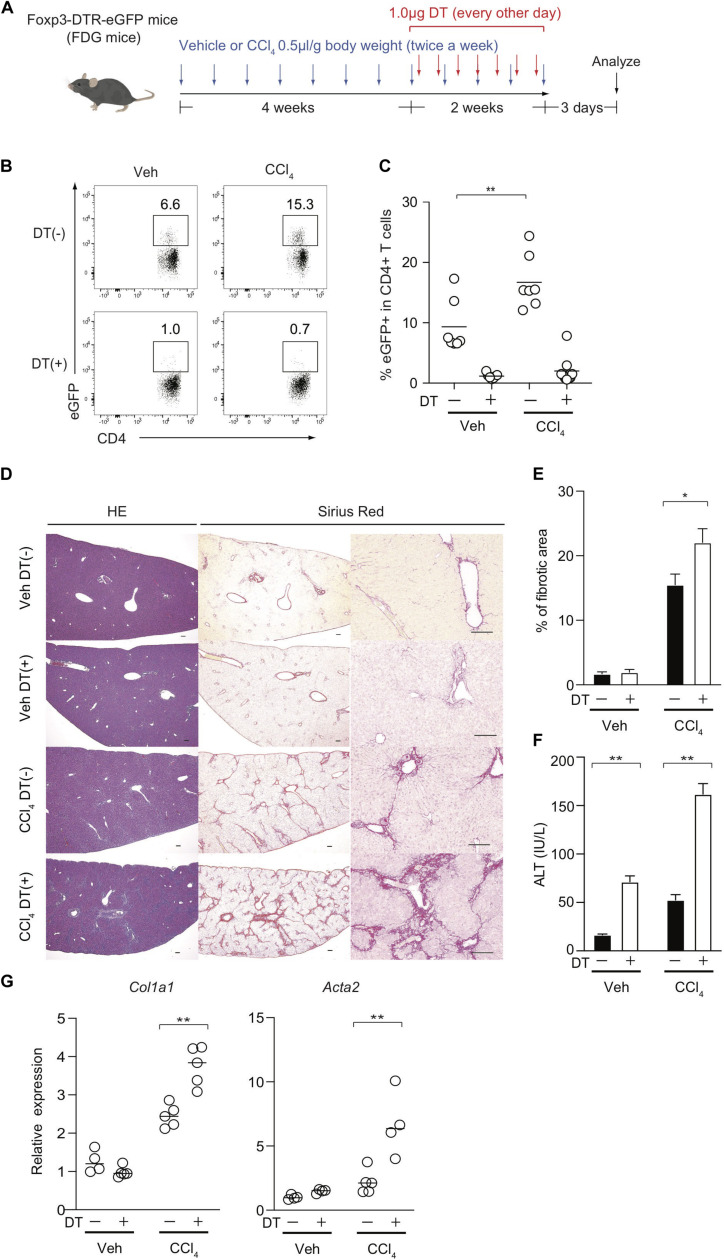
Treg-cell depletion aggravates CCl4-induced liver damage and fibrosis. (A) Experimental design of Treg-cell depletion during CCl4-induced liver injury. FDG mice were untreated or administered diphtheria toxin (DT) during the late phase of CCl4 and vehicle (Veh) treatment. (B,C) Proportions of eGFP+ in hepatic CD4+ T cells of FDG mice with DT(+) or without DT(−) as in panel (A). (D) Representative images of hematoxylin and eosin (H&E) and Sirius red (SR) staining of the liver of DT(−) and DT(+) FDG mice. Scale bars indicate 100 μm. (E) Quantification of fibrotic areas of the liver section evaluated by SR-positive area (n > 5). (F) Serum level of ALT of DT(−) and DT(+) FDG mice (n > 5). Vertical bars denote SD. Horizontal bars indicate the means in pannels (C,G). (G) Quantitative RT-PCR analysis for the expression of Col1a1 and Acta2 (α-SMA) in the liver tissue of DT(−) and DT(+) FDG mice (n = 4). Horizontal bars indicate the means; *p < 0.05, **p < 0.01. Data are representative of two independent experiments in panel (B) and are pooled in panel (C). Data are representative of three independent experiments in panels (E–G).